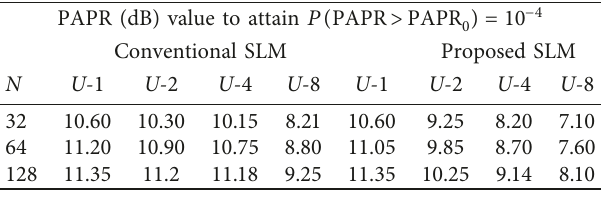
Table 1: CCDF performance investigation of conventional SLM and proposed SLM for N � 32 , 64 , and 128 under U � 1, 2, 4, and 8.